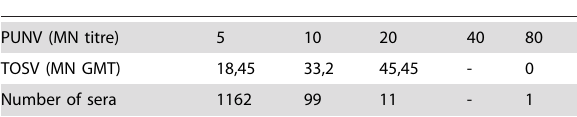
Table 3. Correlation between microneutralisation titre for Punique Virus (PUNV MN titre) and microneutralisation geometric mean titre for Toscana virus (TOSV MN GMT).